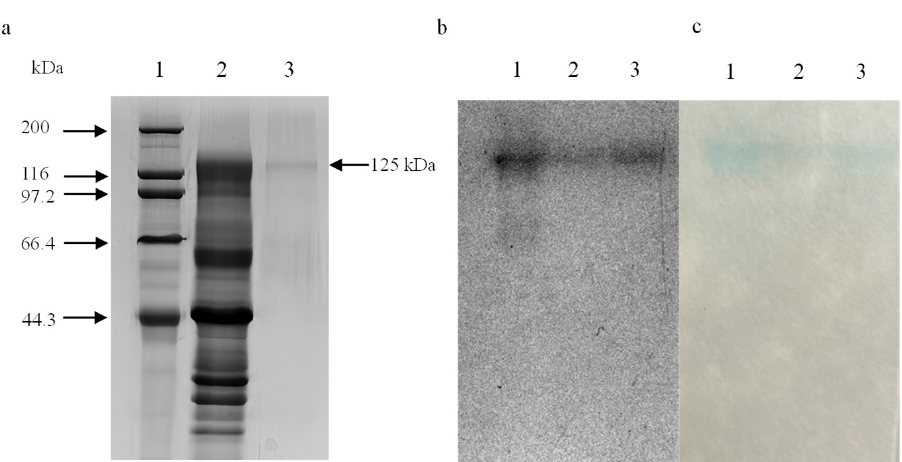
Figure 2. Electrophoretic analysis of α -galactosidase ( a ) 8% SDS-PAGE: Lane 1: Protein marker; Lane 2: Crude enzyme; and Lane 3: Purified enzyme; ( b ) 8% Native-PAGE: Lane 1: Crude enzyme; Lane 2: Purified enzyme; and Lane 3: Purified enzyme after concentration; ( c ) 8% Native-PAGE (similar to ( b